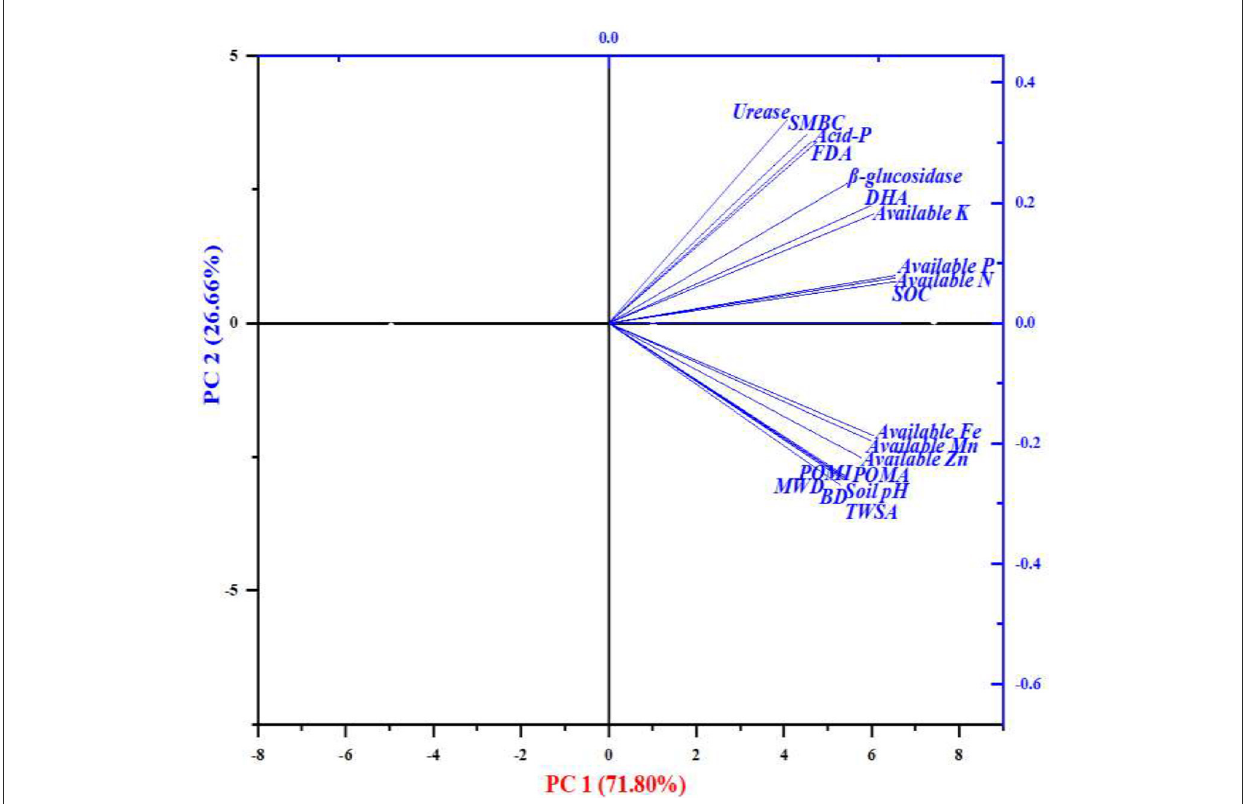
FIGURE6 PCA of the physical, chemical, and biological properties of the soil. POMA, percentage of macroaggregates ( > 0.25mm); POMI, percentage of microaggregates ( < 0.25mm); TWSA, total water-stable aggregates; BD, bulk density (Mg m − 3 ); MWD, mean weight diameter (mm); SMBC,